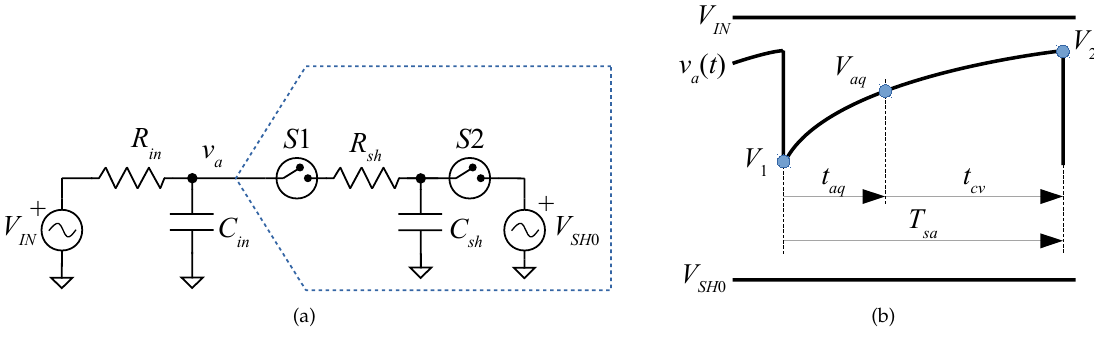
Figure 3. Circuit analysis: ( a ) front-end and sample and hold (SH) schematic, and ( b )